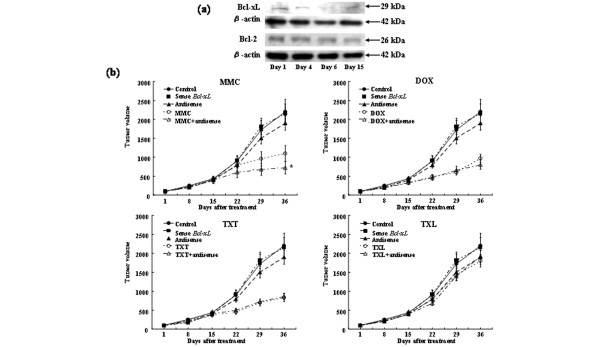
Effects of treatment with antisense Bcl-xL and mitomycin C, doxorubicin, paclitaxel, or docetaxel on MDA-MB-231 cells. (a) Expression levels of Bcl-xL and Bcl-2 protein in MDA-MB-231 cells transplanted into athymic mice after treatment with antisense (AS) Bcl-xL oligodeoxynucleotides (ODNs) were measured by Western blot analysis at the indicated time points. (b) Enhancement of the antitumor effects of anticancer drugs by AS Bcl-xL ODNs in MDA-MB-231 tumor xenografts. Each point represents the mean tumor volume of the four mice in each group. Error bars indicate SD. *, P < 0.05, analysis of variance with Fisher's least significant difference test. The data presented are from two independent experiments. MMC, mitomycin C; DOX, doxorubicin; TXL, paclitaxel; TXT, docetaxel.